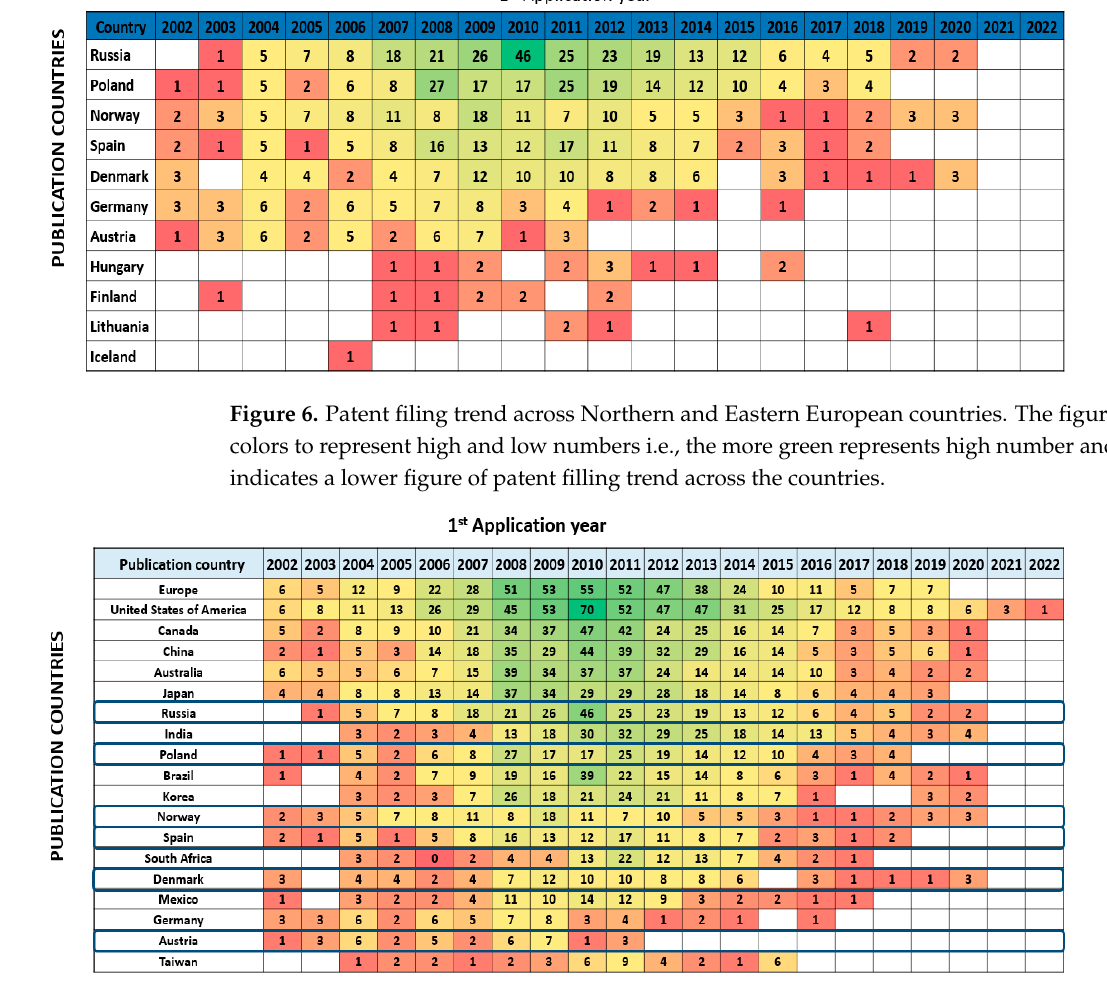
Figure 7. Patent filing trend worldwide. The figure uses two colors to represent high and low numbers i.e., the more green represents high number and more red indicates a lower figure of patent filling trend across the countries.